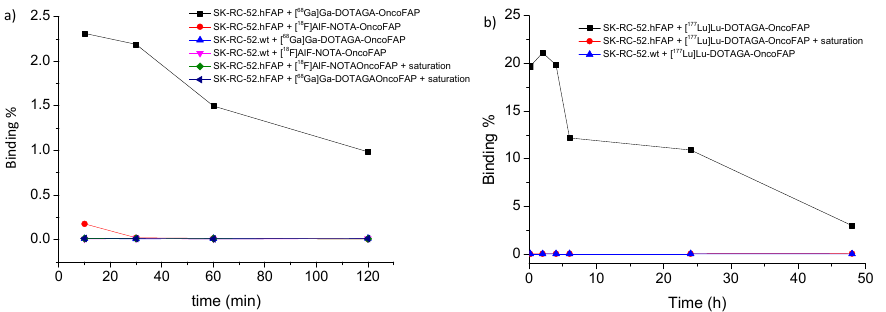
Figure 5. ( A ) Quantitative in vivo biodistribution and ( B ) tumor-to-organ ratios of [ 18 F]AlF-NOTA- OncoFAP in nude mice bearing subcutaneous HT-1080.hFAP tumors. [ 18 F]AlF-NOTA-OncoFAP was intravenously injected at 500 nmol/Kg dose (3.85 MBq/Kg), animals were sacrificed 1-h post- administration and distribution of the radiopharmaceutical was assessed by gamma-counter. 3. Discussion In recent years, the development of tumor-targeting ligands resulted in the discovery of a new generation of diagnostic and therapeutic products with high uptake in cancer lesions and low accumulation in healthy organs. Lutathera ® and [ 177 Lu]Lu-PSMA-617 pro- vide examples of radioligand therapeutics with proven clinical efficacy and limited sys- temic toxicity [17,18]. Radioligand diagnostic and therapeutic products targeting FAP in the tumor microenvironment represent a promising class of compounds with pan-tu- moral applicability and high selectivity for tumor lesions [19,20]. FAP-targeting strategies have gained growing relevance in nuclear medicine for the development of radiolabeling. Although anti-FAP antibodies have been known since the 1990s [21–24], the discovery of small organic FAP ligands in the last few years represented